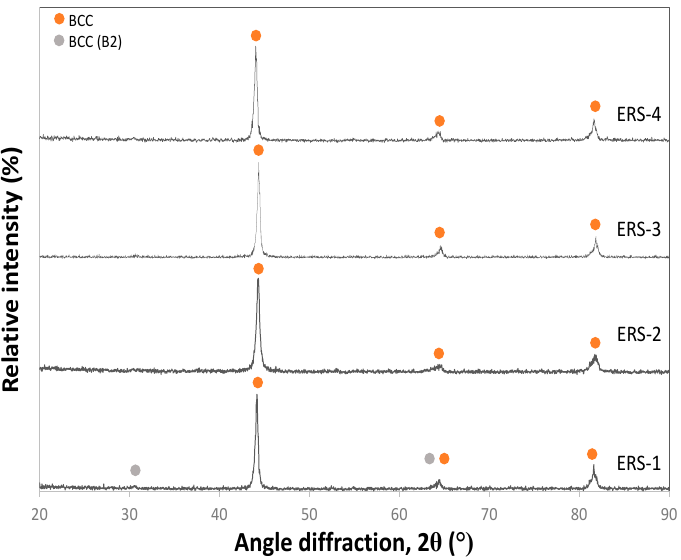
Figure 9. XRD analysis of samples sintered by ERS.